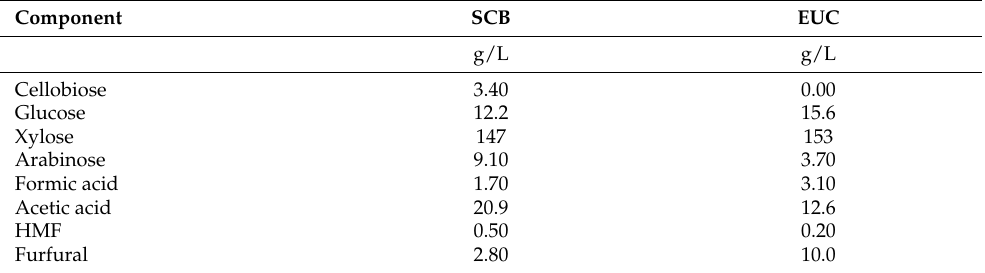
Table 1. Composition of spent liquor after post-hydrolysis.